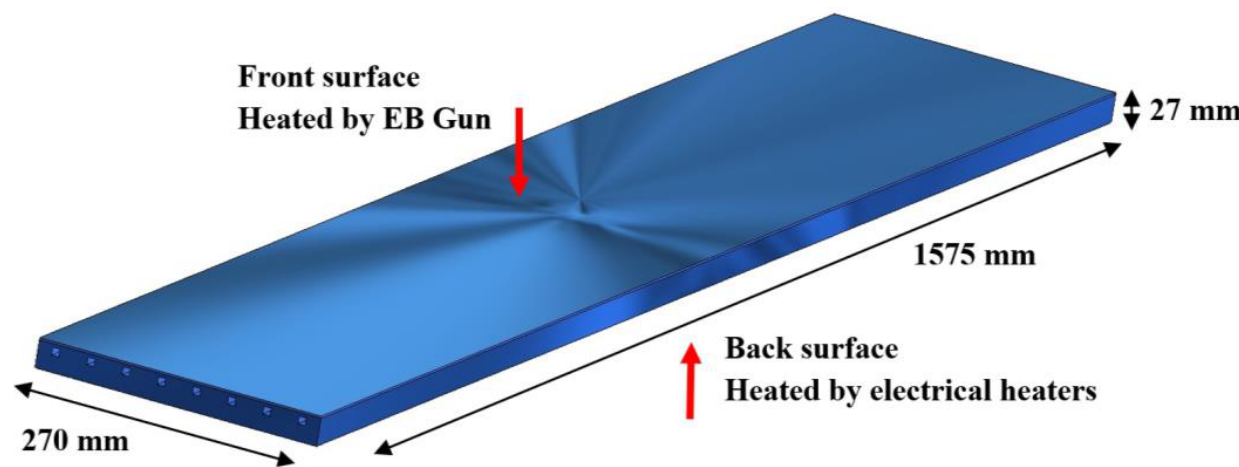
Figure 2. FW – MU layout and dimensions . Figure 2. FW–MU layout and